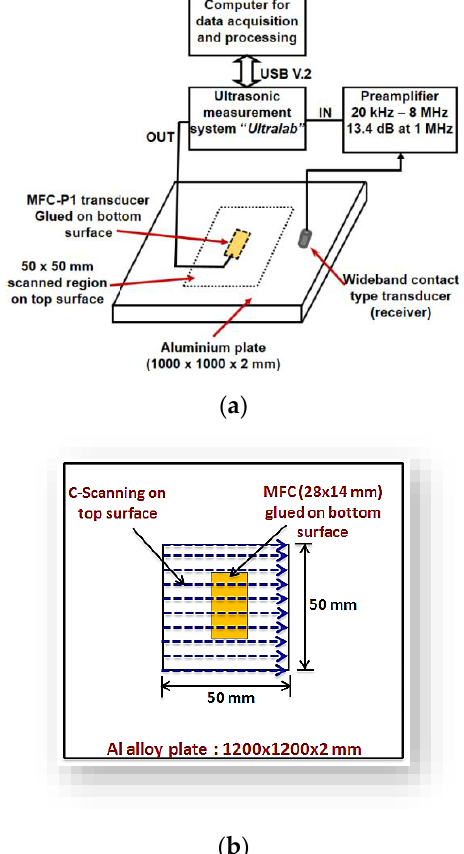
Figure 6. Schematic showing the experimental set-up ( a ) and C-scanning procedure in 50 × 50 mm region on the top surface with MFC glued on the bottom surface of Al alloy plate ( b ).